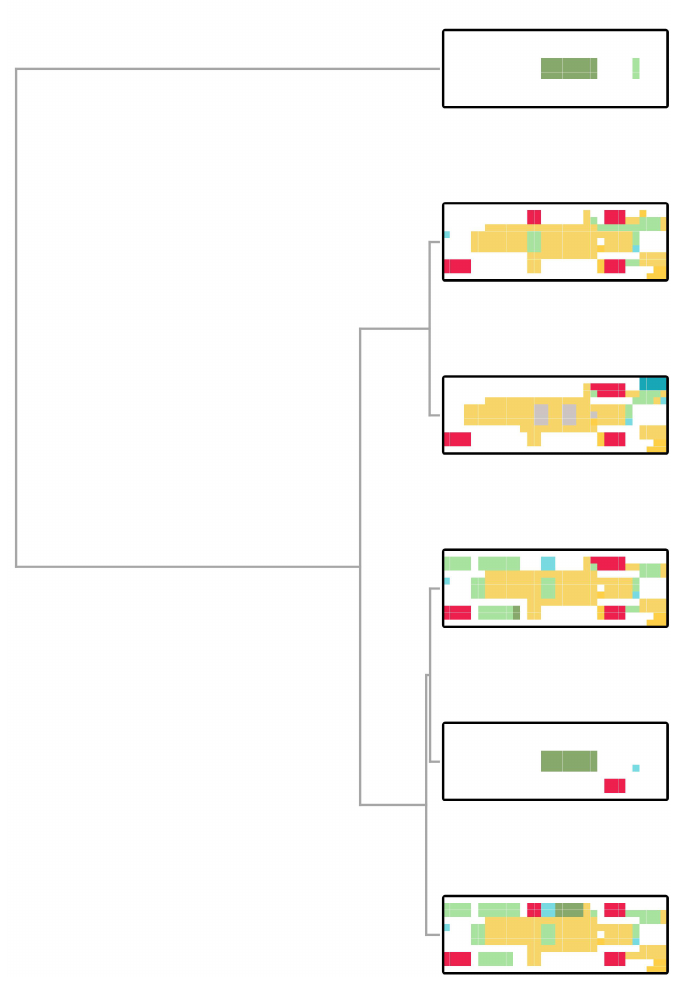
Figure 11. Real case